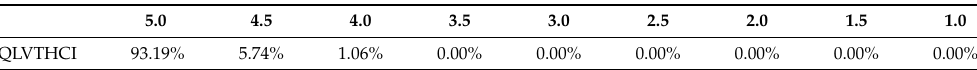
Table 2. Average quality measure obtained from medical experts for slices with different heart parts identified by